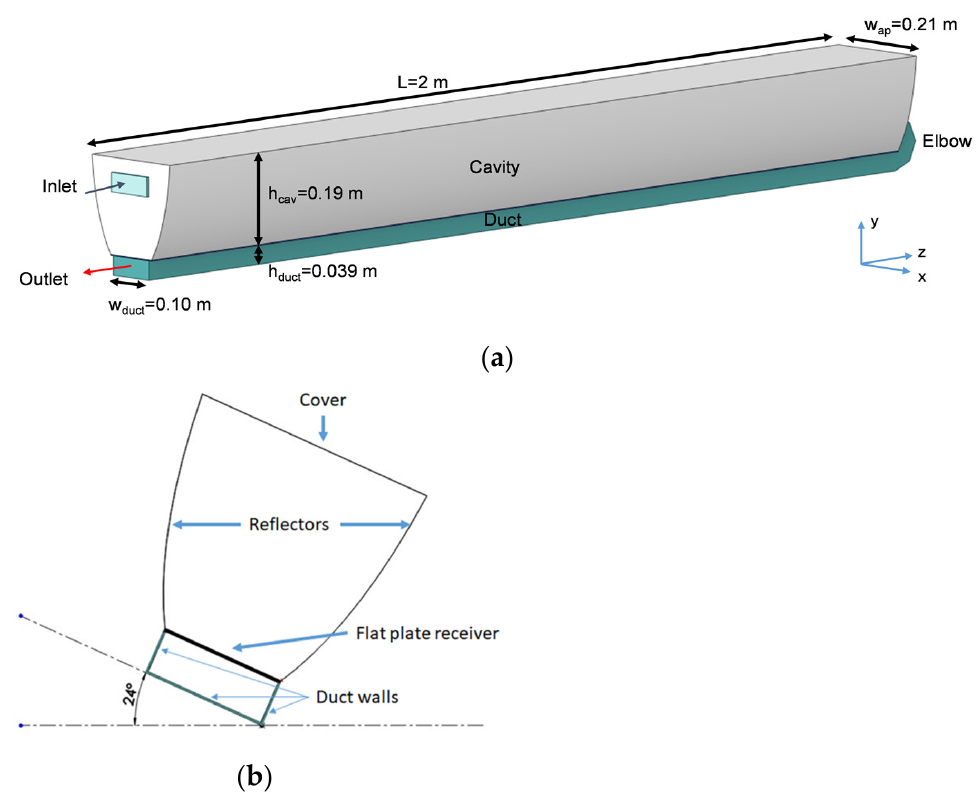
Figure 1. U-shape double-pass CPC solar heater. ( a ) Geometry; ( b ) Cross-section.